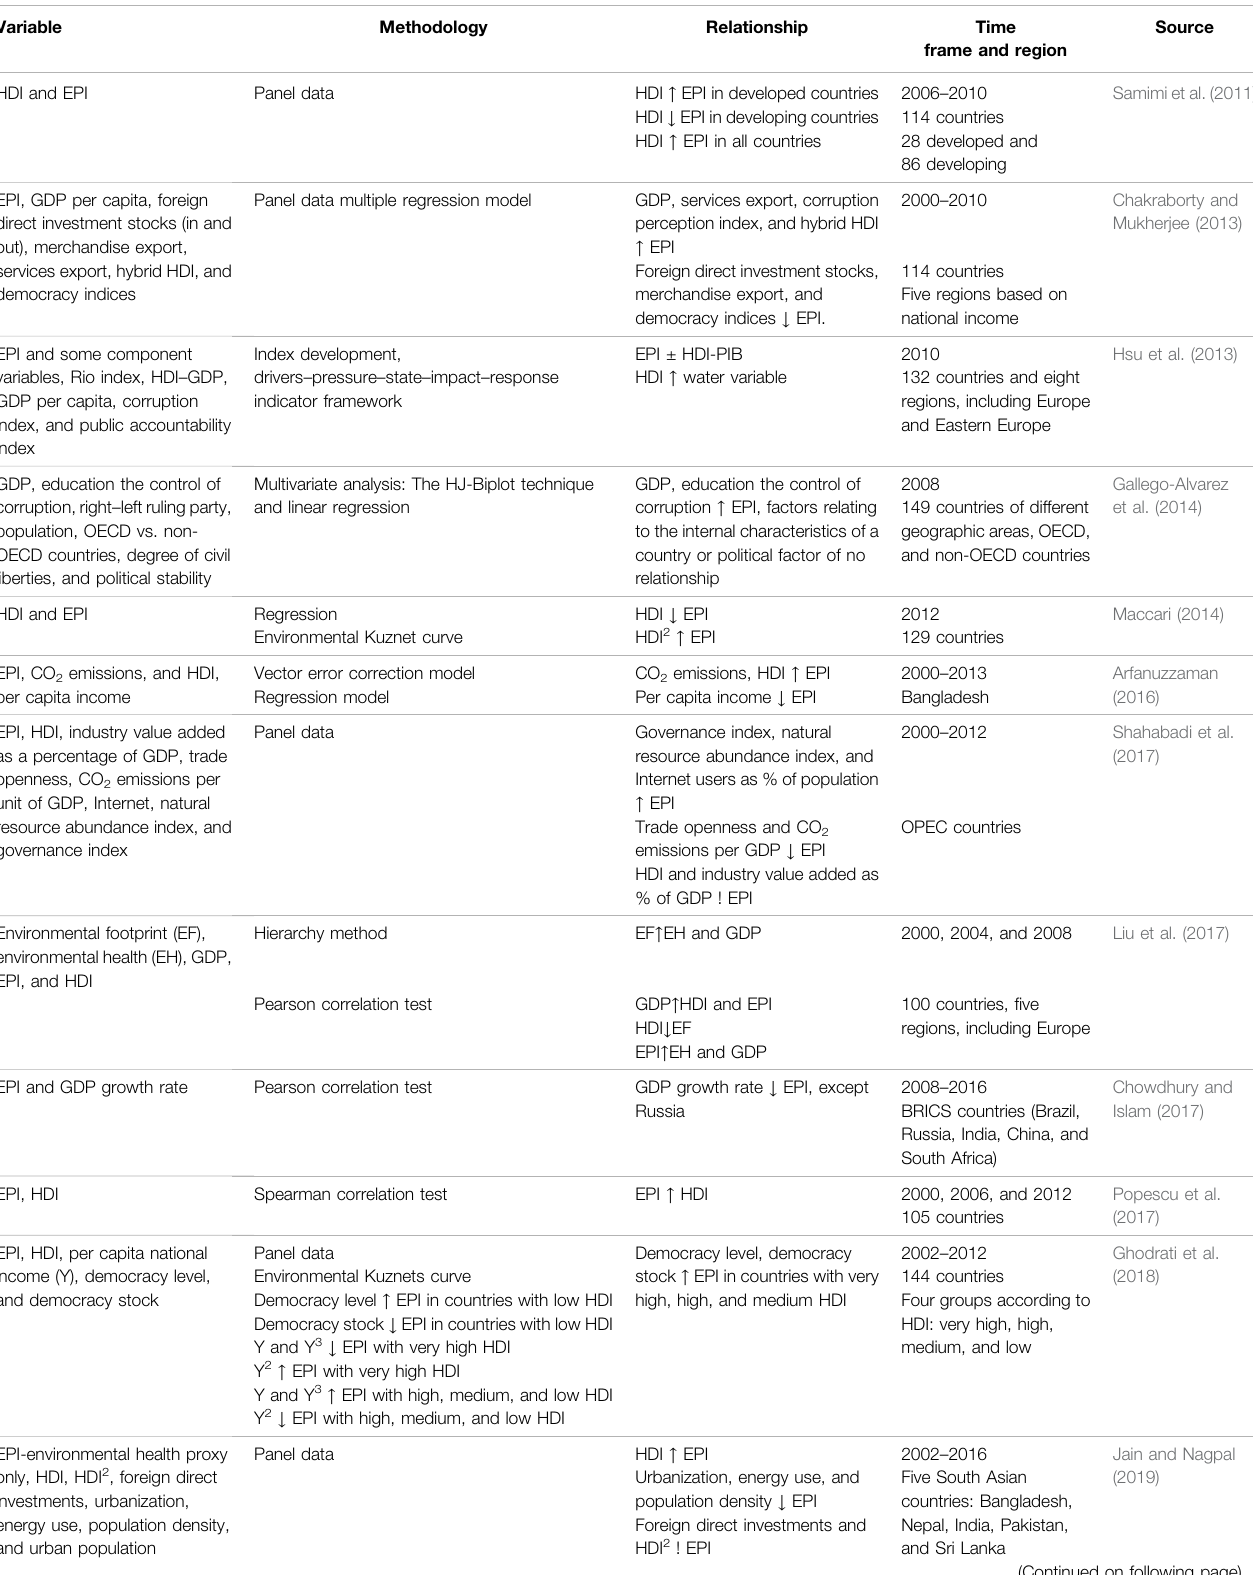
TABLE 1 | Link between Environmental Performance Index and other